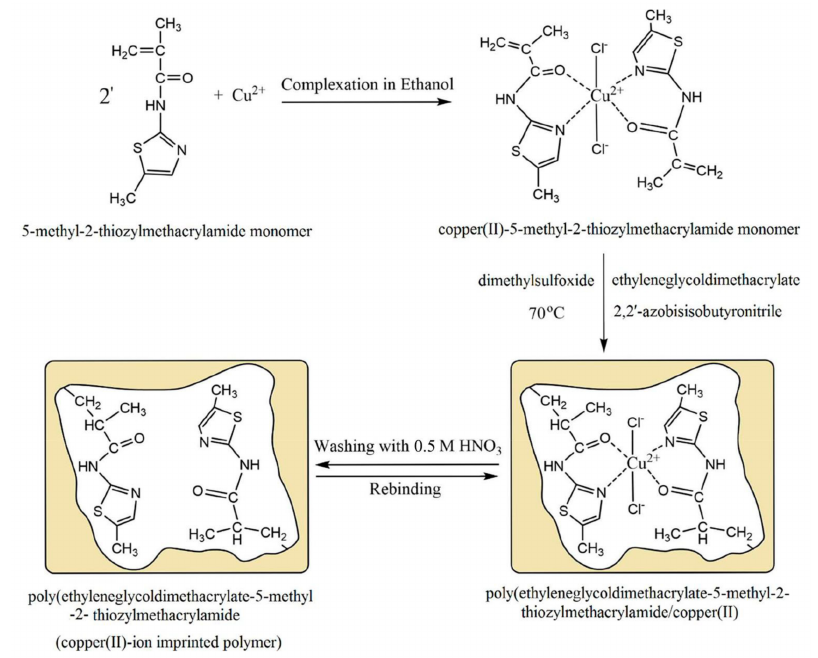
Figure 13. Schematic diagram for the preparation of the copper(II)-ion-imprinted polymer. The acrylamide derivative bearing thiozyl group serves as monomer and ligand in the same time. Adapted with permission of Taylor and Francis from